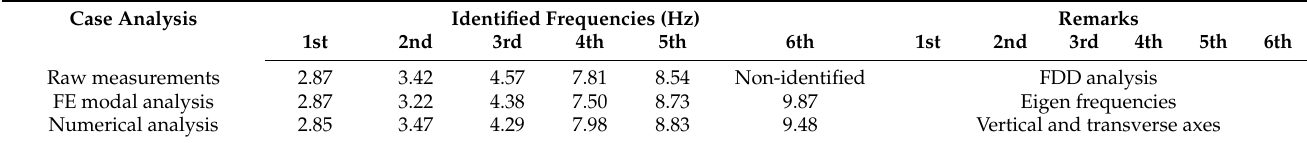
Table 18. Comparison of identified frequency